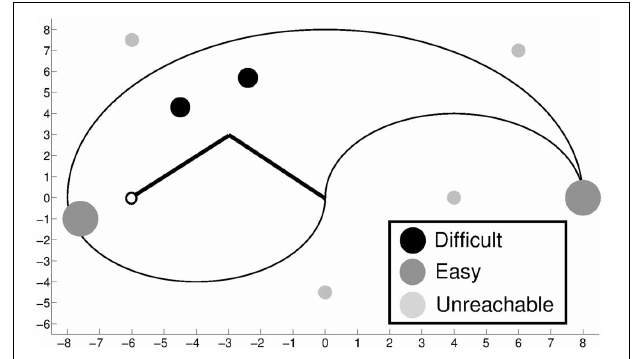
FIGURE 1 | The two dimensional work space of the simulated kinematic robotic arm with the target objects. Small light-gray objects are unreachable by the arm.